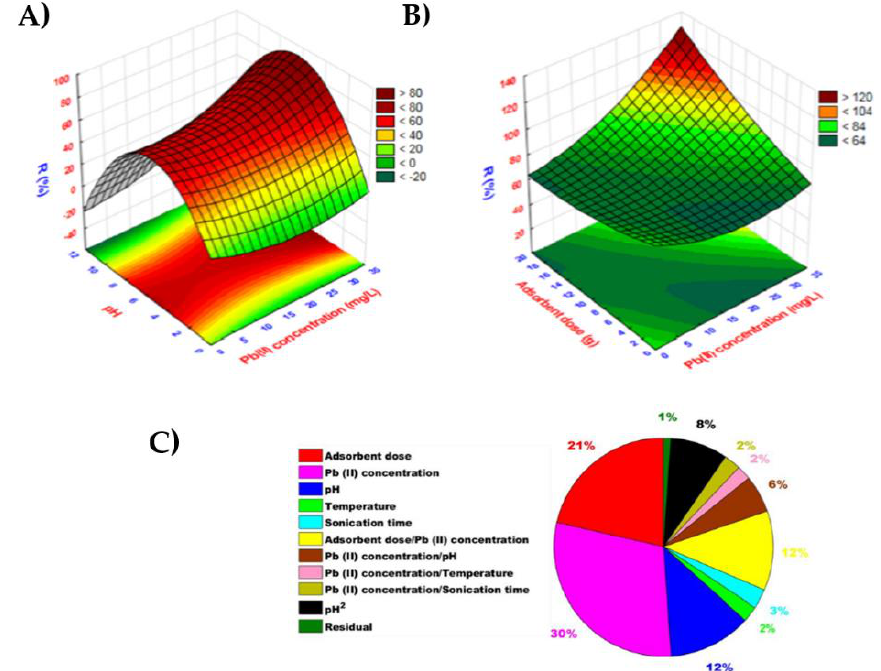
Figure 3. ( A ) three-dimensional response surface plots for the effect of Pb(II) concentration vs. pH; ( B ) the effect of Pb(II) concentration vs. adsorbent dose using GO-chitosan-Fe 3 O 4 -EDTA nanocom- posite; ( C ) Relative importance of adsorption parameters for Pb(II) removal using EDTA grafted GO and magnetic chitosan [41].